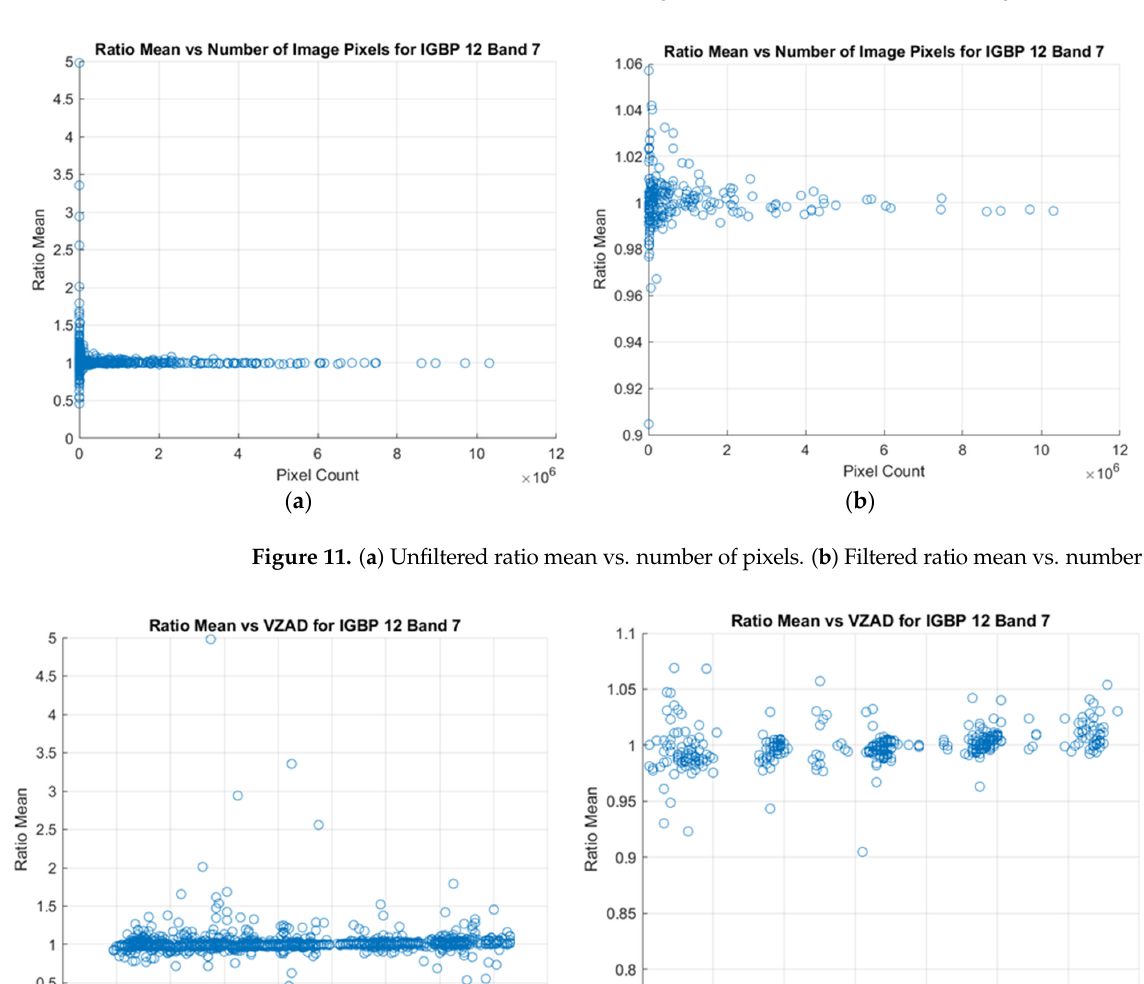
Figure 10. ( a ) Unfiltered ratio mean histogram. ( b ) Filtered ratio mean histogram.